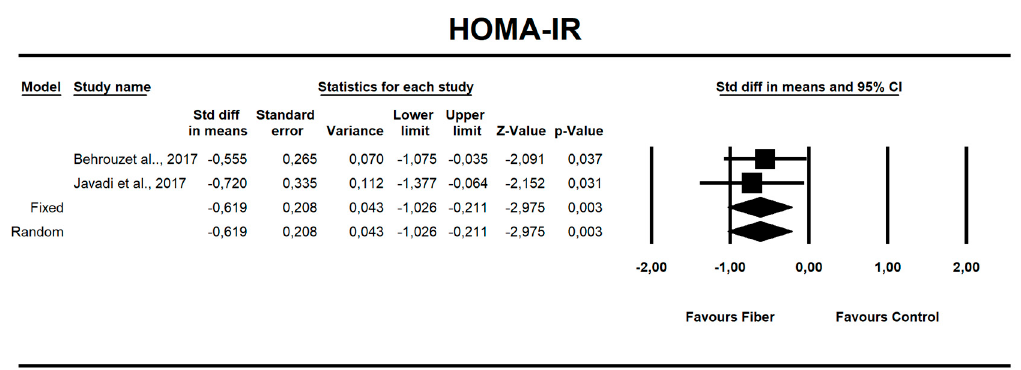
Figure 9. Effect size and standardized mean difference (SMD) for homeostasis model assessment for insulin resistance (HOMA-IR) in people supplementing fiber vs. controls. Q = 0.150, df(Q) = 1, p = 0.698, I-squared = 0.0.